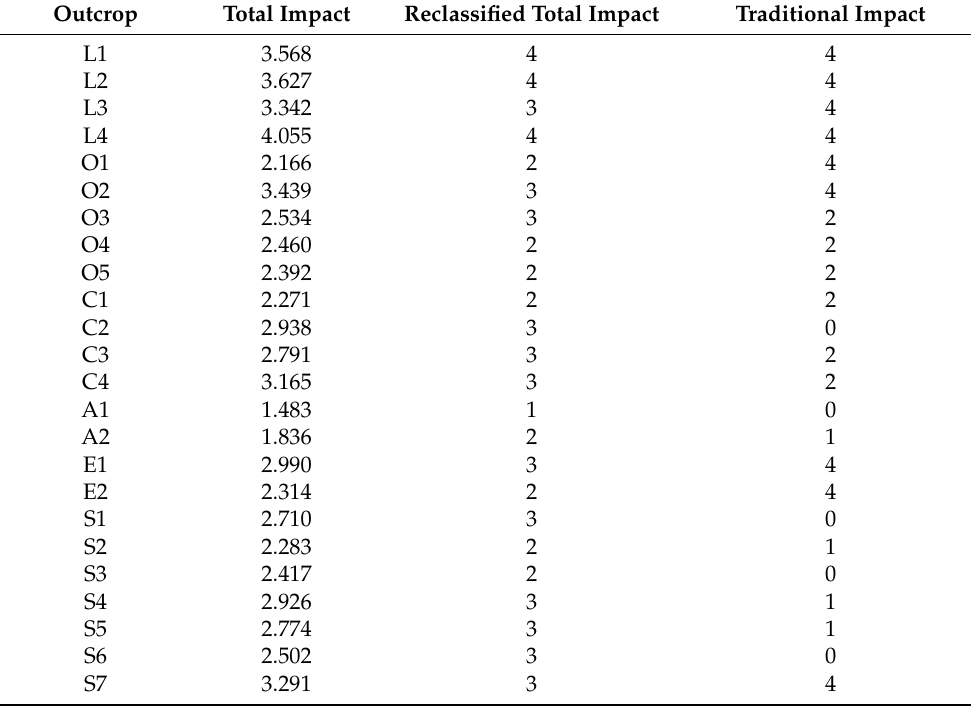
Table 14. Results of the environmental impact for each outcrop.